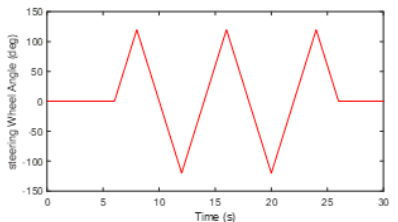
Figure 18. Steering wheel angle during the slalom test.